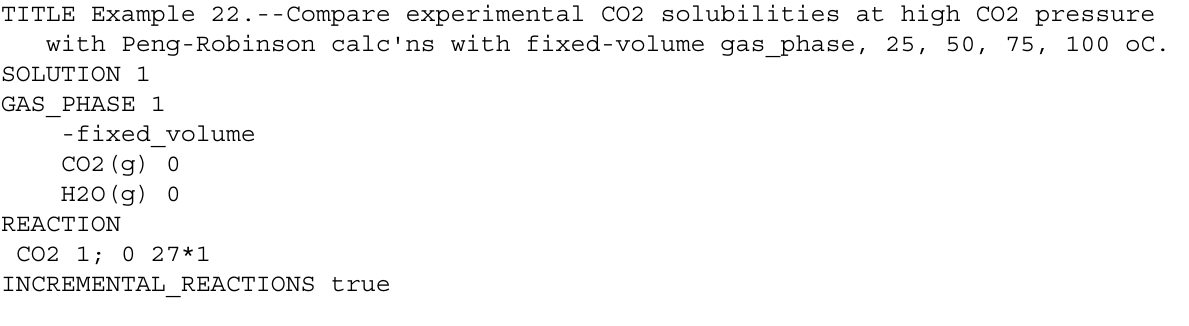
Table 61. Input file for example